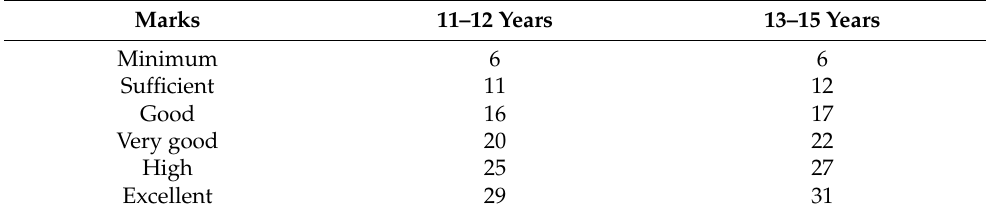
Table 2. Standards for individual age